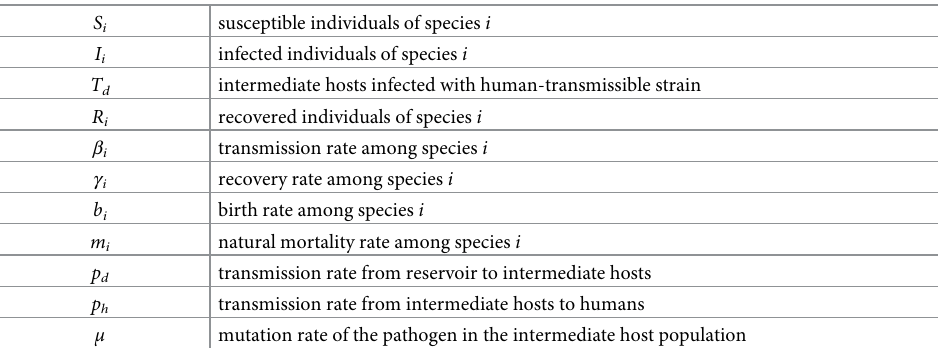
domestic population. The model does not account for coinfection in a domestic animal, since an individual infected with both strains is still capable of starting a human epidemic and is thus counted in the T category. For each species, the model’s value at equilibrium is given by at most a quadratic equation, giving two possible equilibria in each compartment. At the disease-free equilibrium E have S ¼ b i for each species i , while the endemic equilibrium E i m i values shown in Table 4. We use the next-generation method ([32] and [33]) to calculate R giving